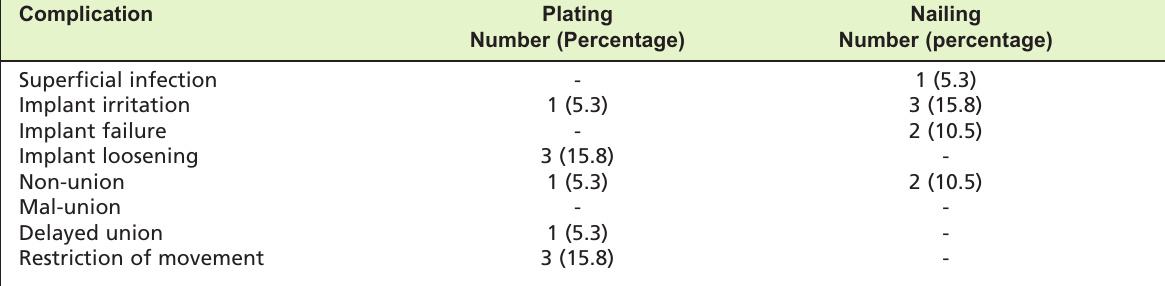
Complications following plating and Table III: